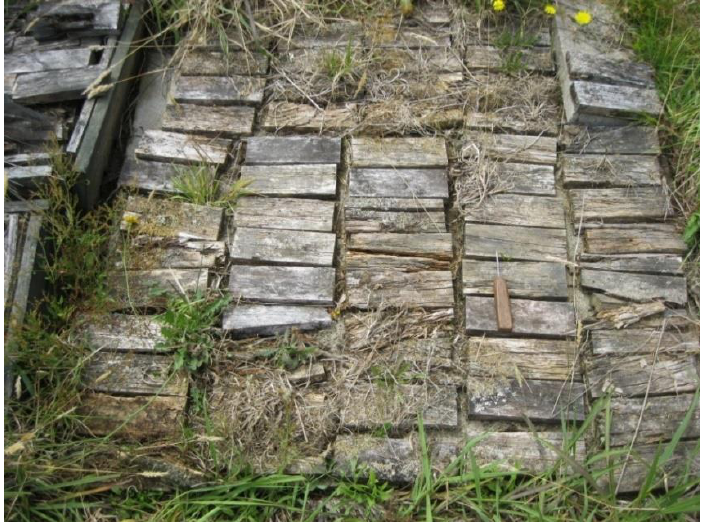
Figure 5. Ground proximity test after 10 years exposure. The samples were originally covered with shade cloth but this was damaged and debris from mowing the surrounding grass supported vegetation growth between and on samples. Most of the samples, including preservative-treated, ones were in poor condition.